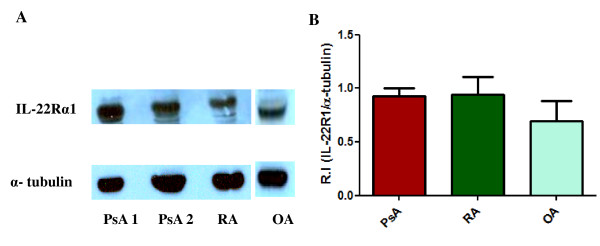
Western blot analysis of IL-22Rα1 expression in FLS of PsA, RA and OA patients. Expression of IL-22Rα1 in FLS isolated from PsA (n = 5), RA (n = 5) and OA (n = 5) patients was assessed. (A) A representative western blot showing expression of IL-22Rα1 in PsA, RA and OA patients. (B) A bar diagram showing relative intensity (R.I) of IL-22Rα1 expression in FLS obtained from PsA, RA and OA patients. Results were expressed as Mean ± SEM. Non parametric test, Kruskal Wallis with Dunn's multiple comparison test was done to determine the statistical significance.